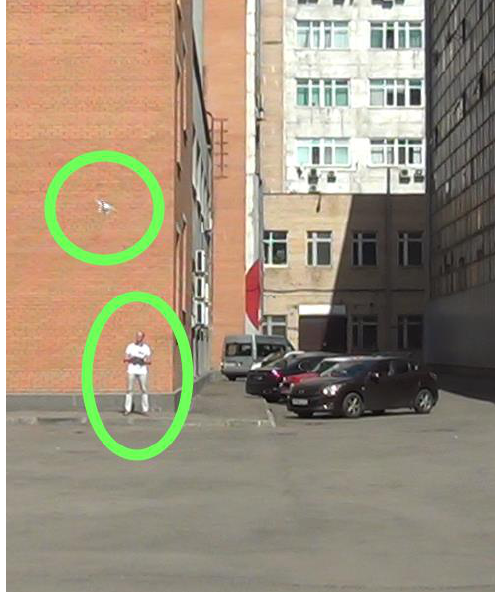
Fig. 4. Optical image of the scene corresponding to a radar image on figure